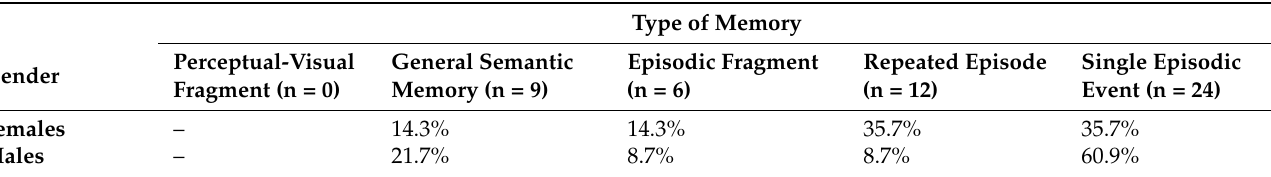
Table 5. Frequencies of the different types of memories reported by females and males in epoch 1 (the different types of memory reported are 51).